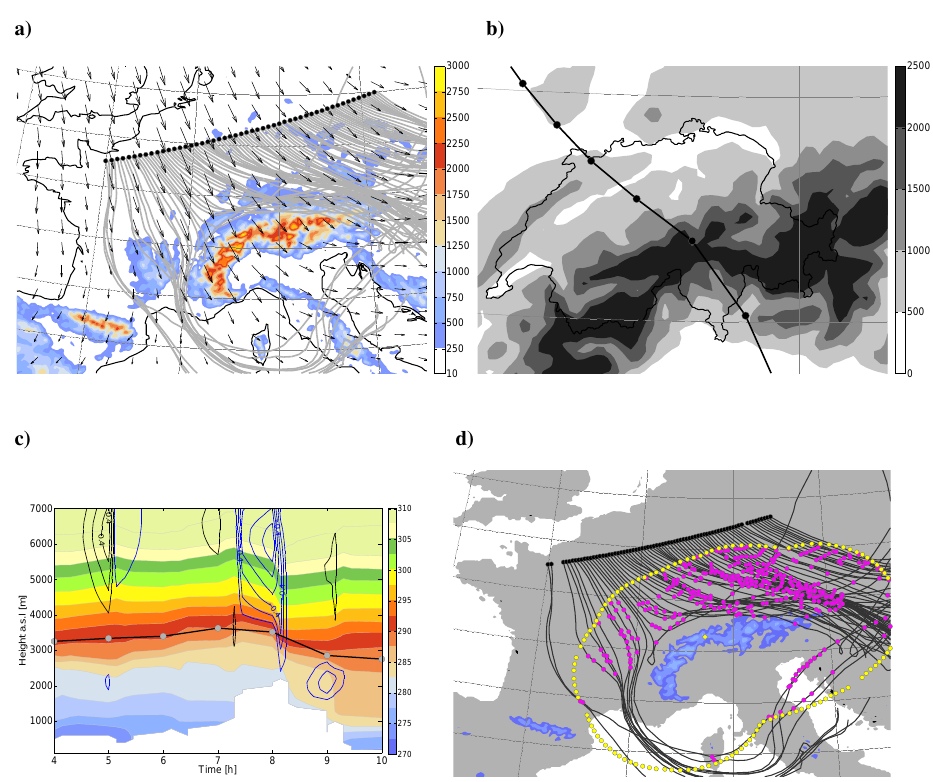
Figure 5. (a) Starting positions (black dots) and 48h forward trajectories (grey lines) started at 09:00UTC on 28 January 2009; additionally shown are the topography (in m) in color, and the wind arrows at 500hPa at the trajectory starting time; (b) trajectory passing over the Gotthard Pass (topography shown in m as grey shading). Time intervals of 1h are marked along the trajectory by filled circles; (c) vertical profiles along the Gotthard trajectory with time as the horizontal axis and heighta.s.l. as the vertical axis. Potential temperature (in K) is shown in color, vertical velocity (in ms − 1 ) as black (upward) and blue (downward) contours. The vertical evolution of the trajectory is shown as a bold black line with markers (filled circles) every hour; (d) trajectories that reach at least 90% relative humidity within the spherical polygon outlined by the small yellow dots, corresponding to a distance of 300km of the 1500m height contour of the Alps. The yellow dot over Switzerland defines the interior of the spherical polygon. Magenta dots mark the positions where RH >